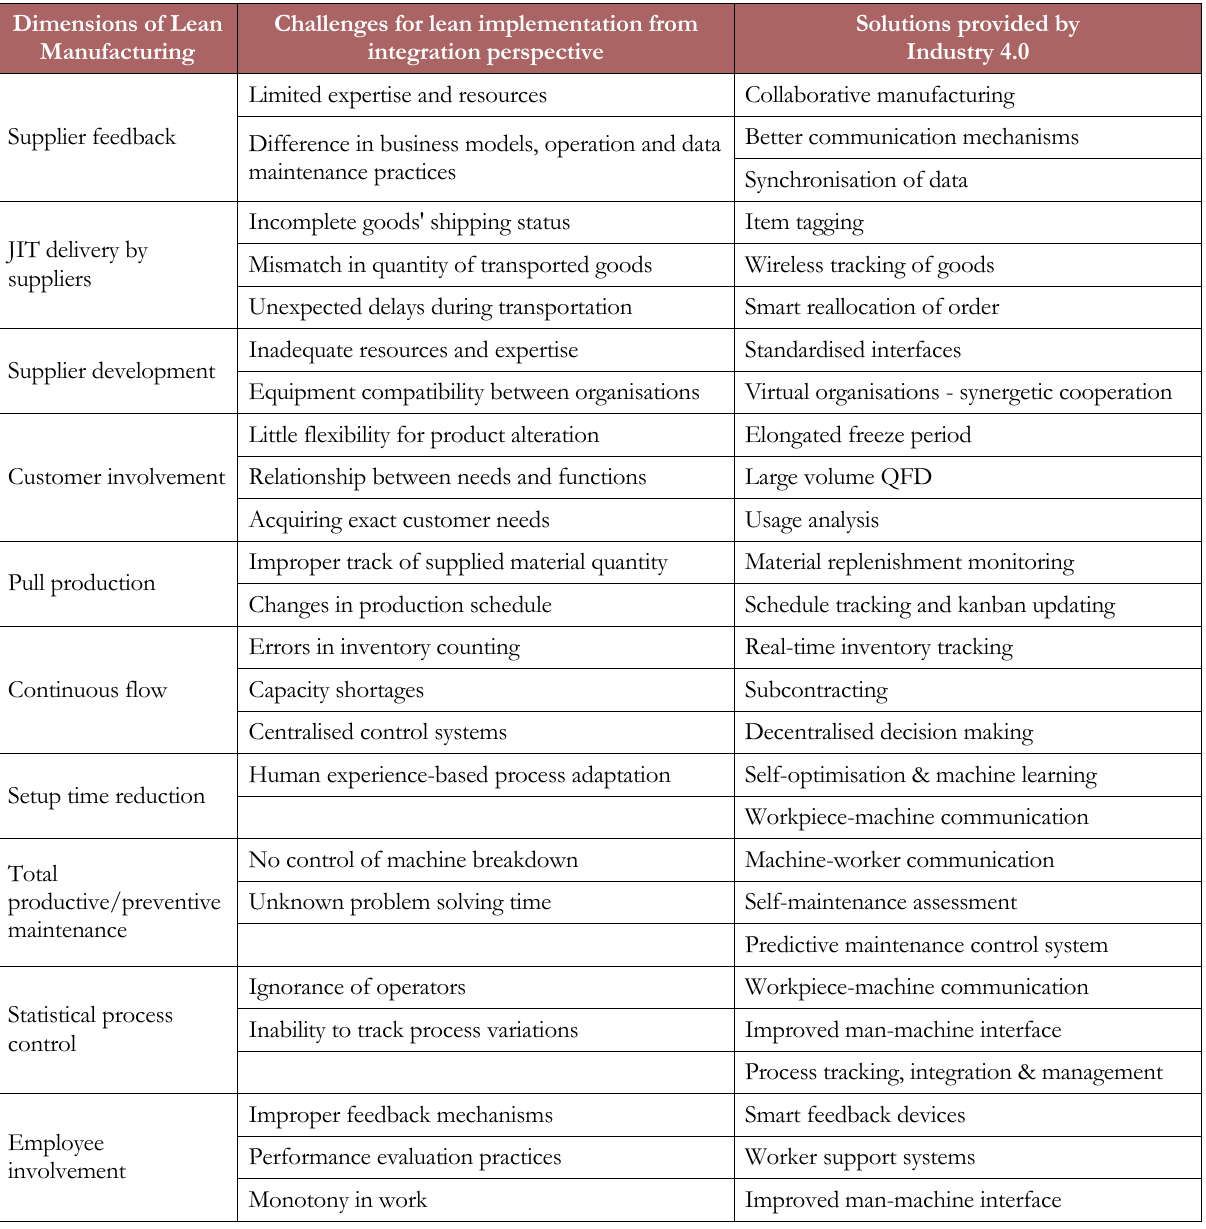
Table 1. Summary of lean dimensions, challenges and